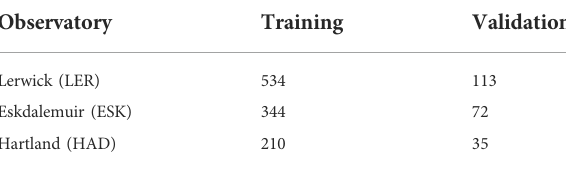
TABLE 2 Number of event days included in the training and validation sets for each observatory.